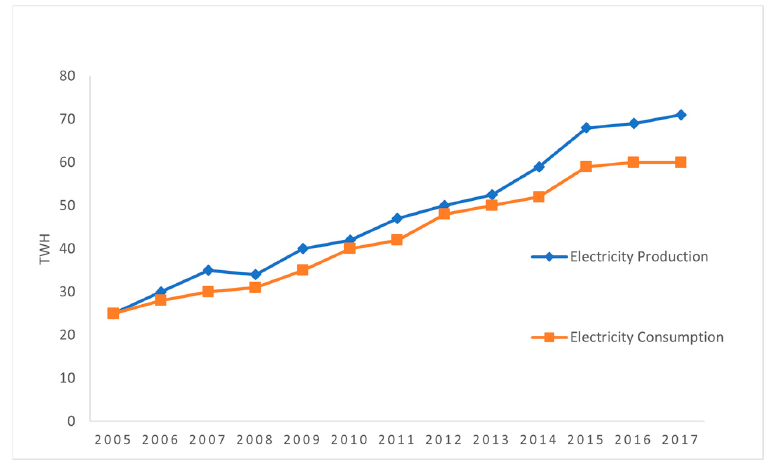
Figure 2. Electricity production and consumption of Abu Dhbai, UAE [Data adapted from [38]).